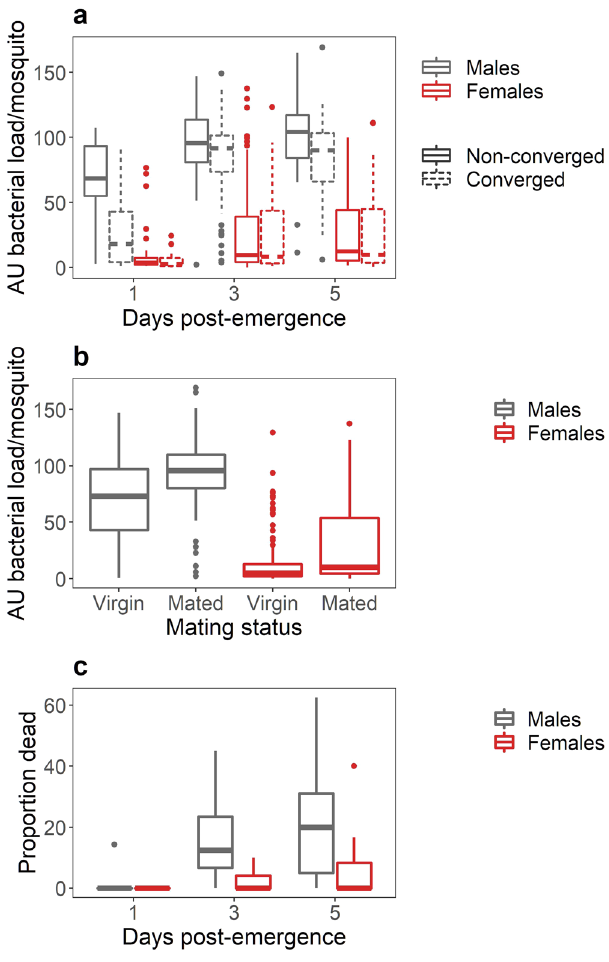
Fig. 2 The effect of sex, age, and harmonic convergence on bacterial growth and mosquito mortality. Bacterial growth of Escherichia coli after 24 h in vivo incubation in Aedes aegypti mosquitoes injected with 200,000 live bacteria and housed at 27 °C ( n = 577). Boxes are boxplots of the interquartile range with medians for each treatment group, whiskers represent the fi rst and third quartiles, and points are outliers in the data. Males and females are represented by the colors gray and red, respectively. a The effect of sex, age, and parental convergence status on bacterial growth. Solid and dotted lines represent mosquito offspring from parental pairs that did not converge and that did converge, respectively. Signi fi cant pairwise comparisons are indicated in Table S4. b The effect of mating status (Virgin or unmated vs. Mated) on bacterial growth for males (gray) and females (red) ( n = 305 observations). c The effect of mosquito age (Days Post-Emergence) on the mortality of male (gray) and female (red) mosquitoes 24 h post-challenge with live bacteria ( n = 121 observations). offspring derived from converged and non-converged parental pairs (survival of >95%). model above (Table S6), the nested model con fi rmed that parental convergence status does not affect the overall proportion of mosquitoes infected, with disseminated infection, or infectious with DENV. However, convergence status did appear to in fl uence the temporal dynamics of these response variables within each tissue. Viral prevalence in the bodies of offspring from converging parental pairs increased over time (linear: effect, estimate = 4.58,